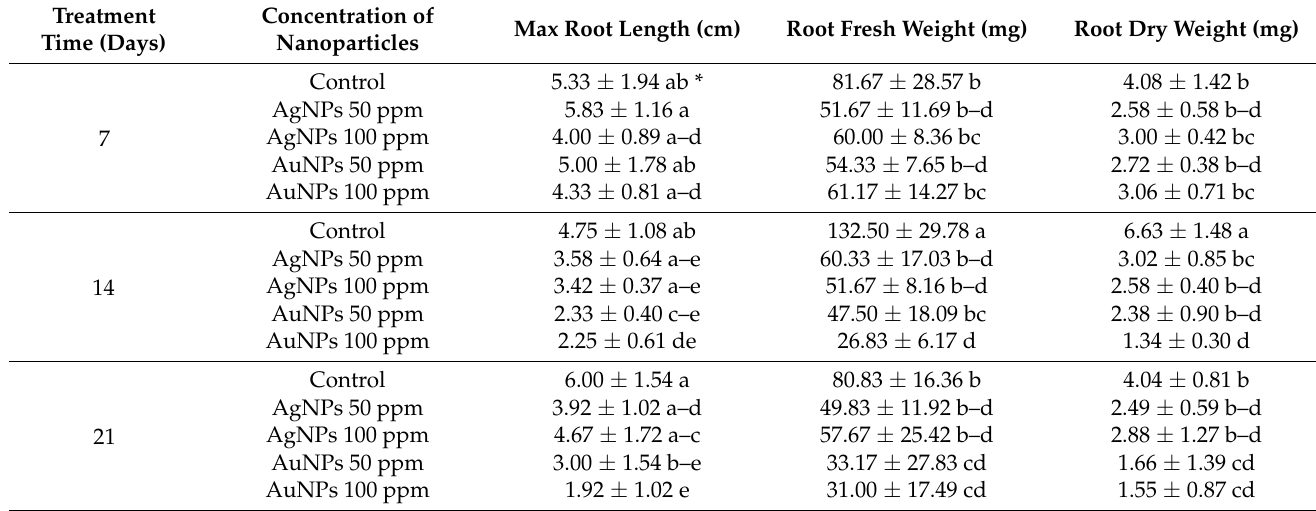
Table 2. Comparison of the influence of nanoparticles’ type and concentration on the root length and fresh and dry weight of rapeseed